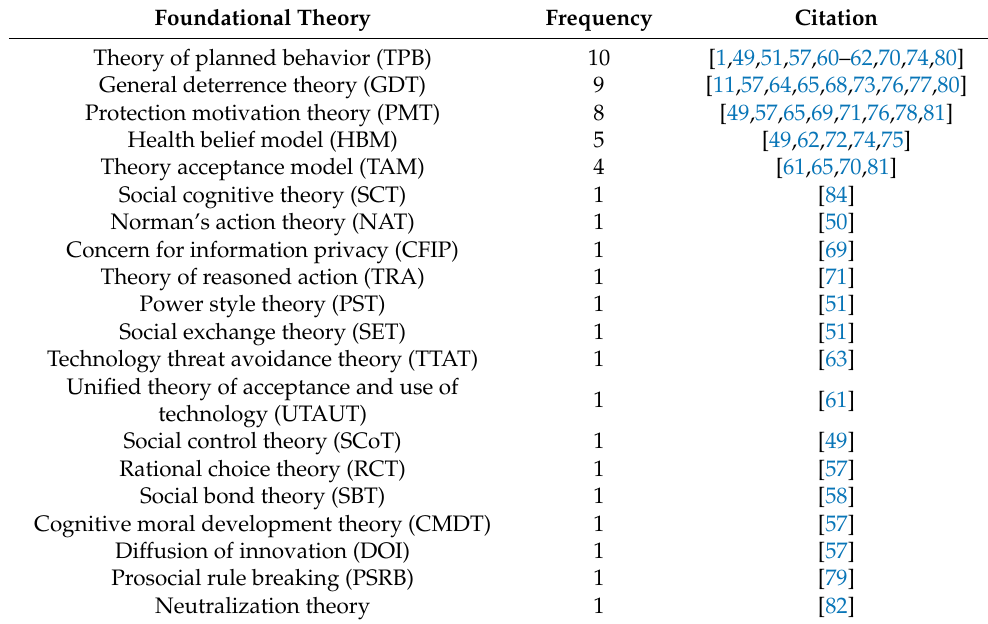
Table 6. Foundational theories in the selected